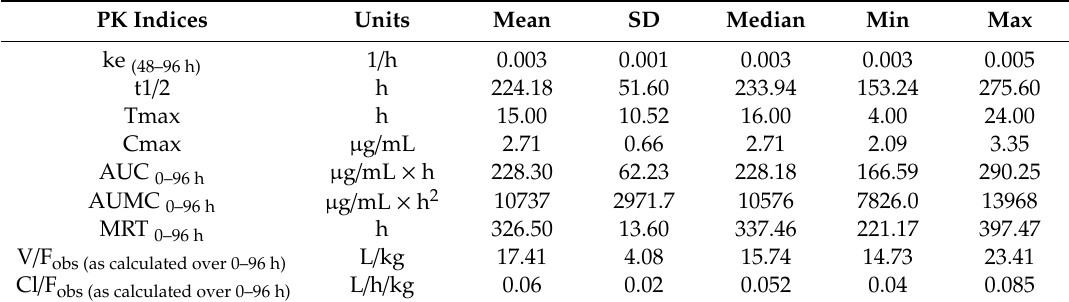
Figure 2. Mefloquine plasma concentrations (ug/mL) over the first 24 h after cats were administered 62.5 mg (10–12 mg/kg) mefloquine at t = 0.